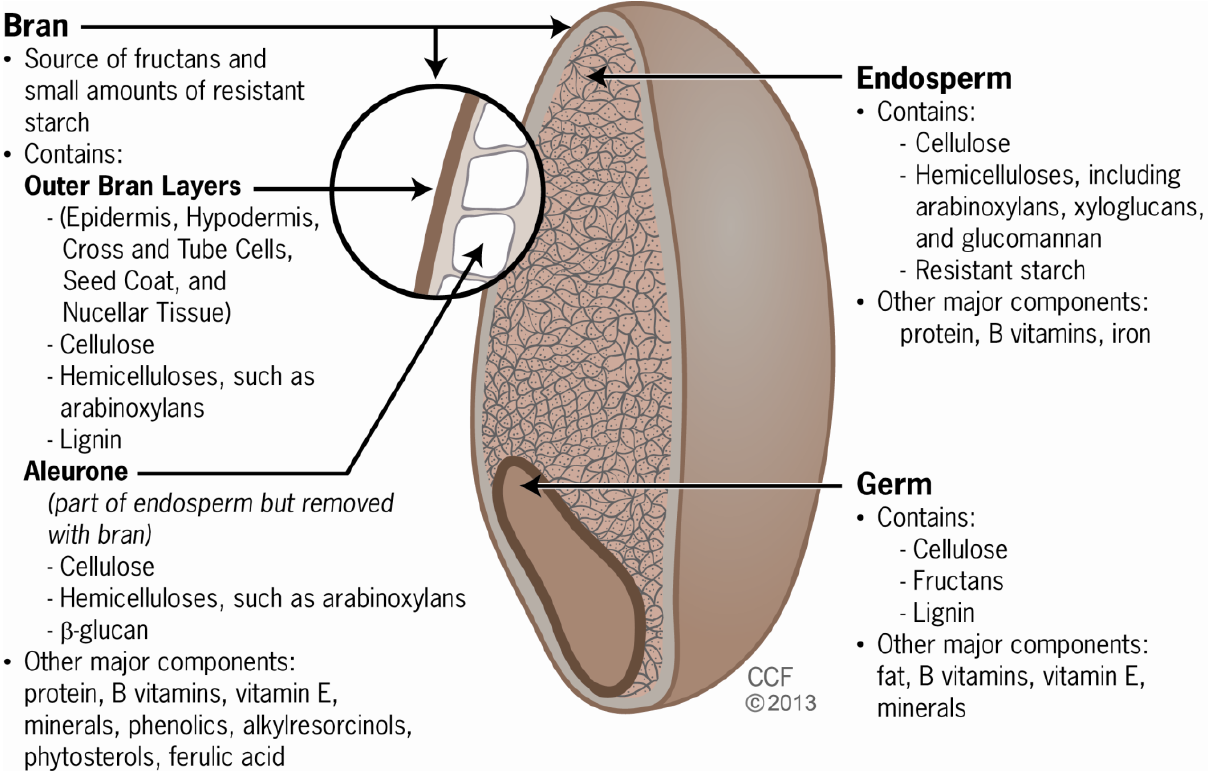
Figure 1. Fibers of the Wheat